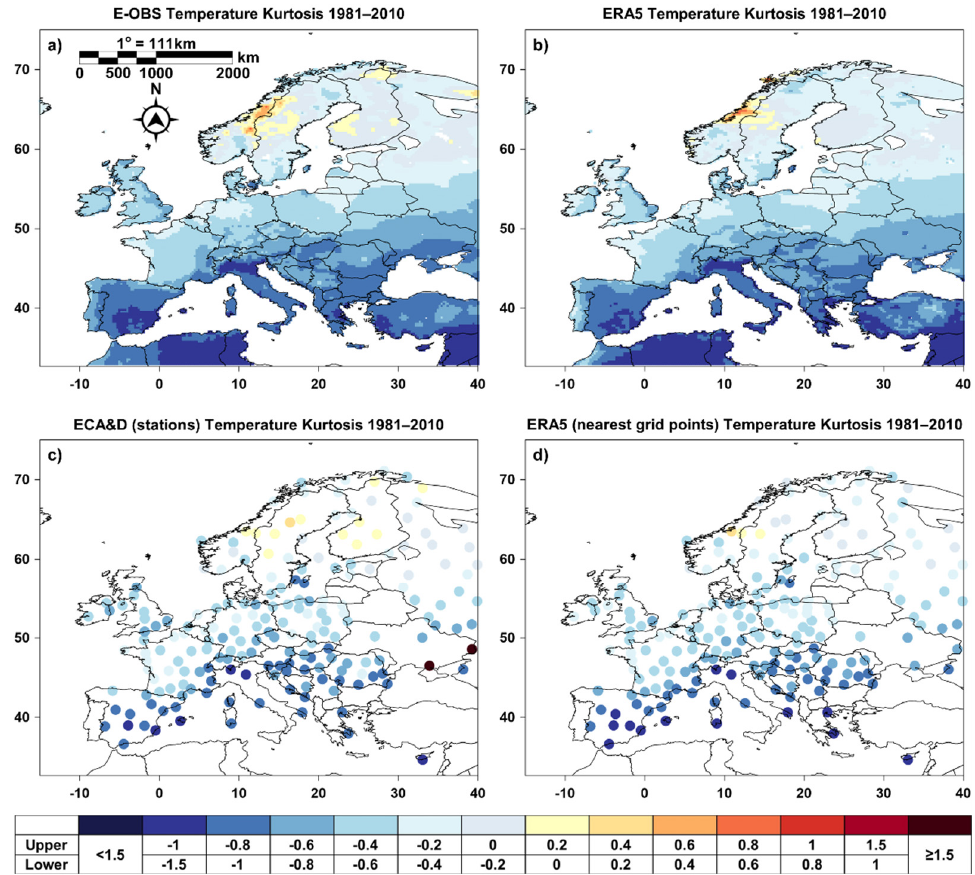
Figure 8. Temperature kurtosis excess for ( a ) E-OBS, ( b ) ERA5, ( c ) ECA&D stations and ( d ) the nearest to the stations grid points from the ERA5.